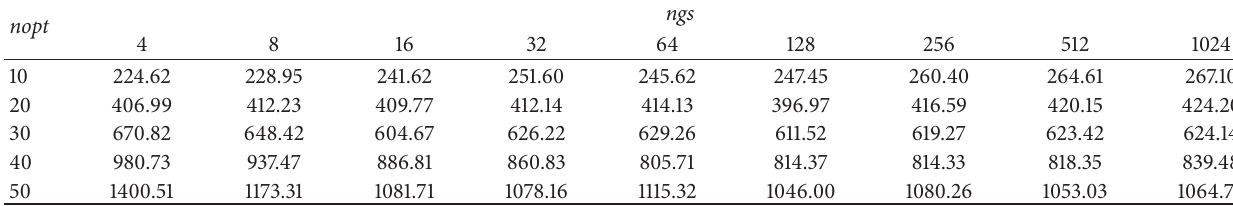
Table 3: Total execution time (seconds) of the CUDA-SCE-UA.